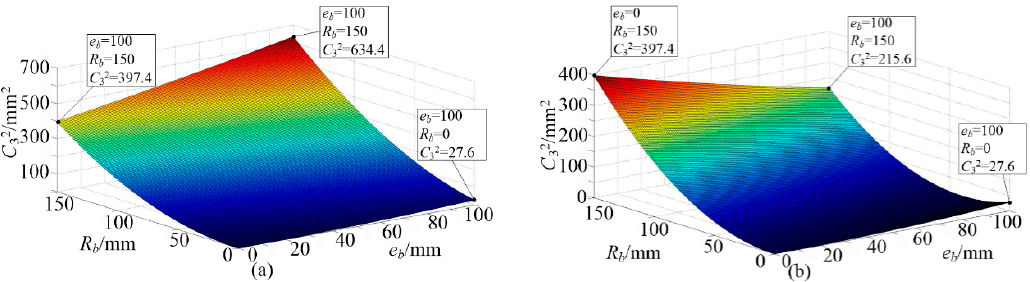
Figure 8. Change surface map of C 3 . ( a ) corresponds to β b less than 0, ( b ) corresponds to β b greater than 0.